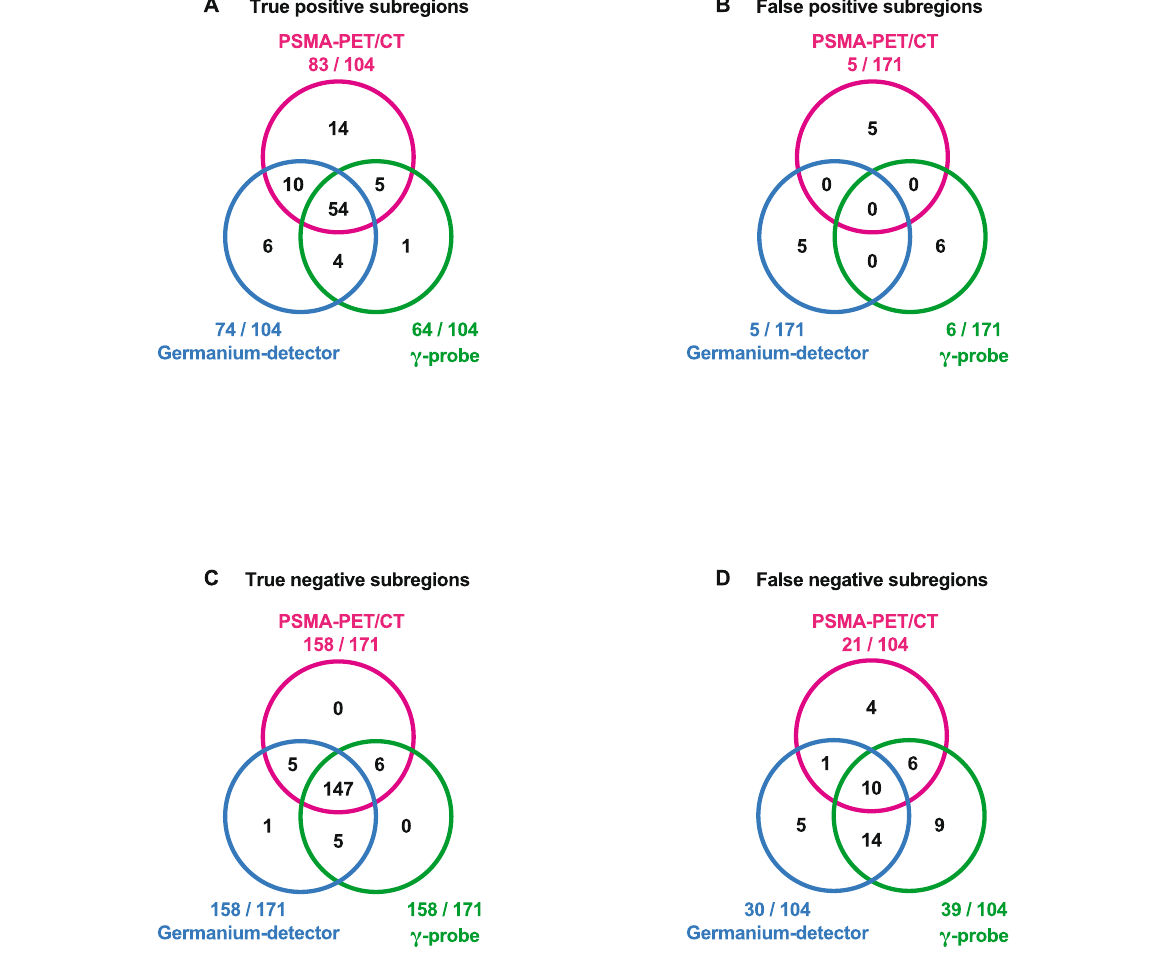
Fig. 5 a – d Venn diagrams illustrating the intersections between the results of PSMA-PET/CT, tracer uptake determined with the germanium detector and ex situ γ -probe measurements. Intersections for a true-positive, b false-negative, c true-negative and d false-positive subregions in 104 subregions with histologically proven metastases and 171 subregions free of metastases